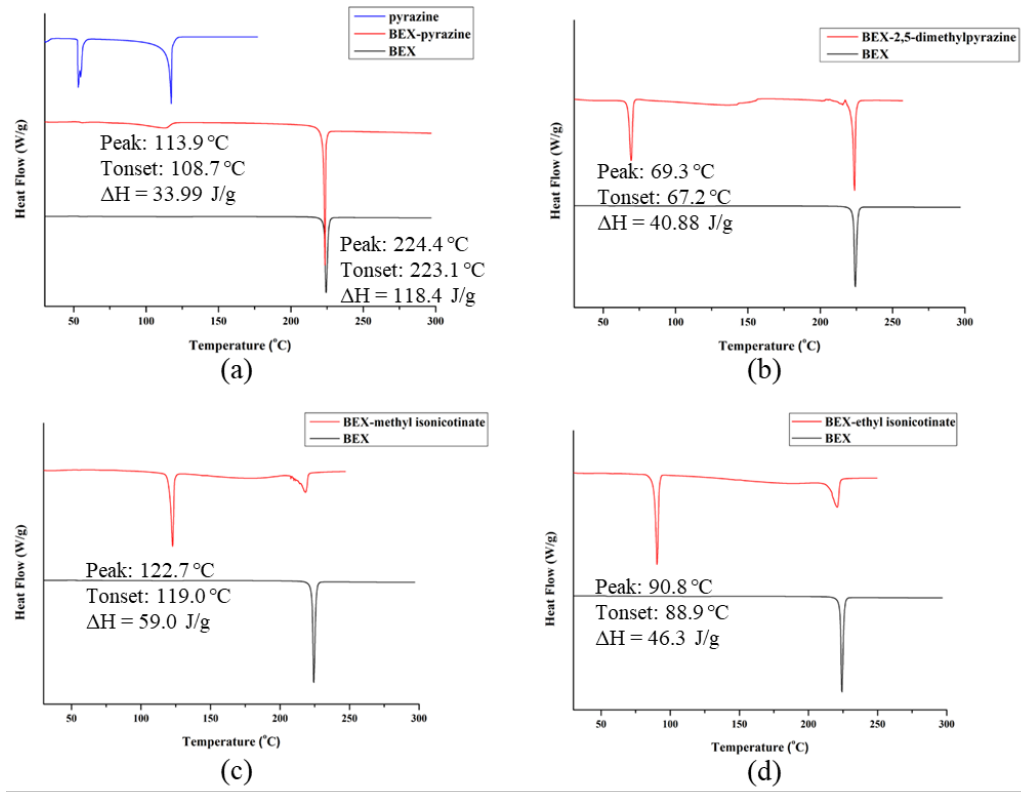
Figure 7. DSC profiles of solid forms of BEX: ( a ) BEX-pyrazine, ( b ) BEX-2,5-dimethylpyrazine, ( c ) BEX-methyl isonicotinate, and ( d ) BEX-ethyl isonicotinate.